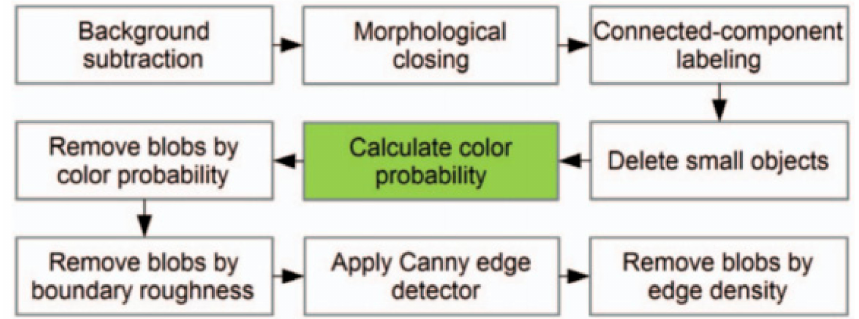
Figure 6. Flood detection algorithm developed by Filonenko A. et al. (2015) [109].